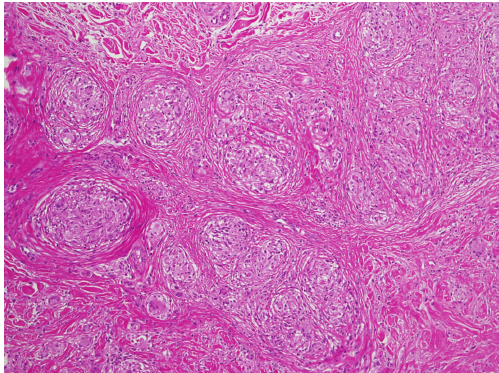
Figure 4: Biopsy of a superficial elbow nodule. Pathologic findings showed evidence of epithelioid granuloma surrounded by a rim of lymphocytes (hematoxylin and eosin stain, ×